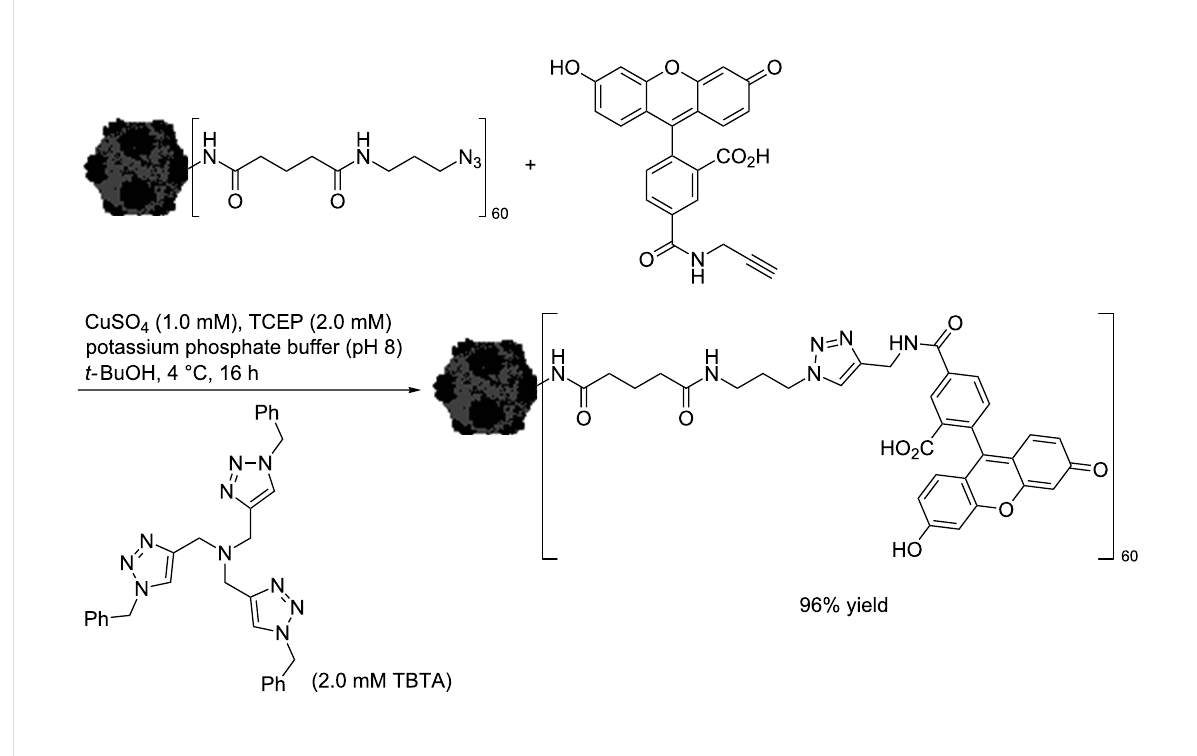
Scheme 3: Bioconjugation reaction of capsid-bound azide groups with alkynyl-functionalized dye molecules (cowpea mosaic virus is presented by an image of its crystal structure as published by the group of Lin in 1999)